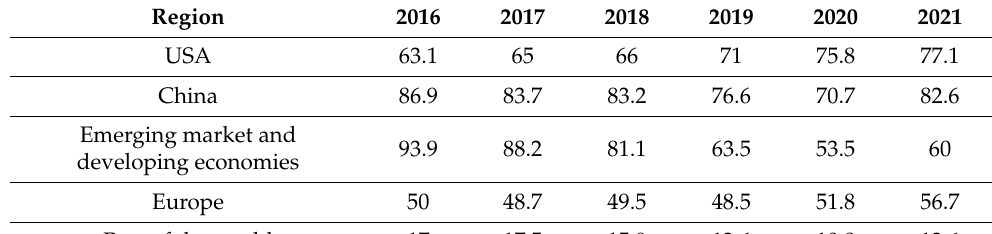
Table 4. Investment spending in electricity networks by region, 2016–2021 in USD billion.